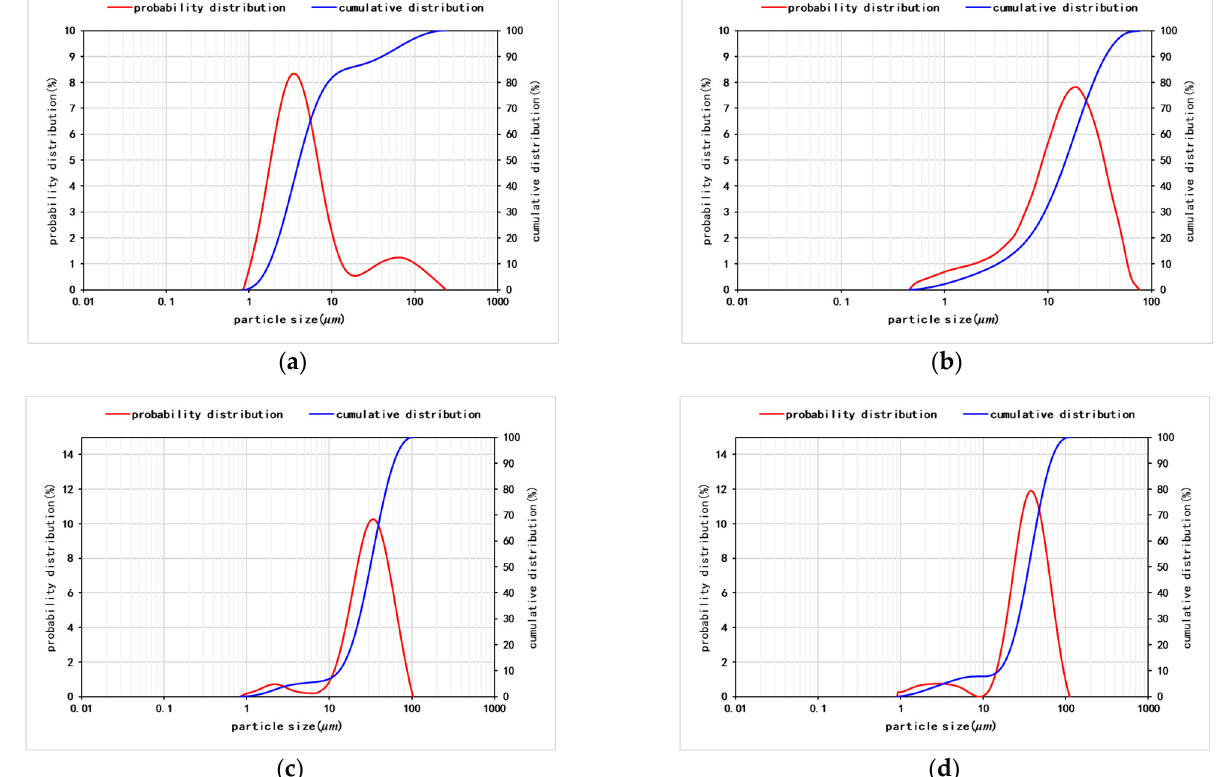
Figure 3. The particle size test results of nano-microspheres under different standing times. ( a ) The newly prepared dispersion on ( b ) day 1, ( c ) day 2, and ( d ) day 3.